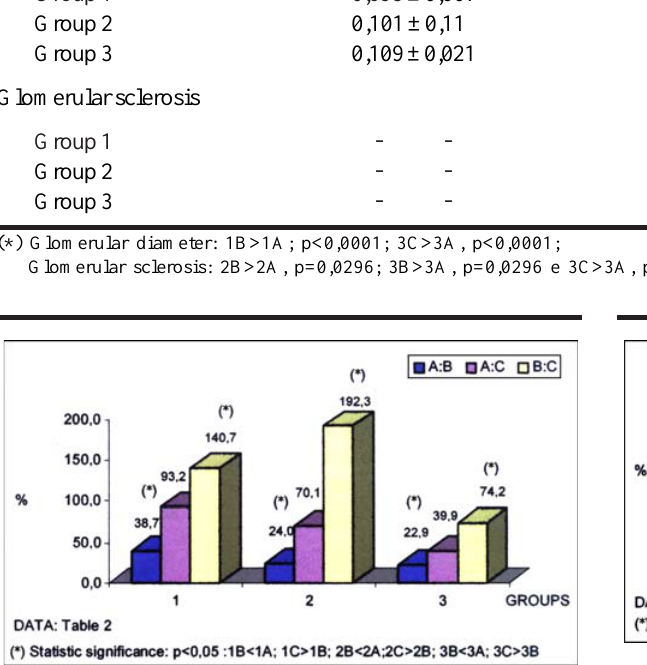
FIGURE 1 - Percentual of residual renal function FIGURE 2 - Percentual of renal mass